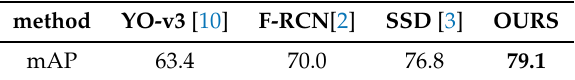
Table 8. Comparisons with the state-of-the-art methods on PASCAL VOC. The YO-v3 indicates the YOLOv3 method. The F-RCN means the Faster RCNN method.